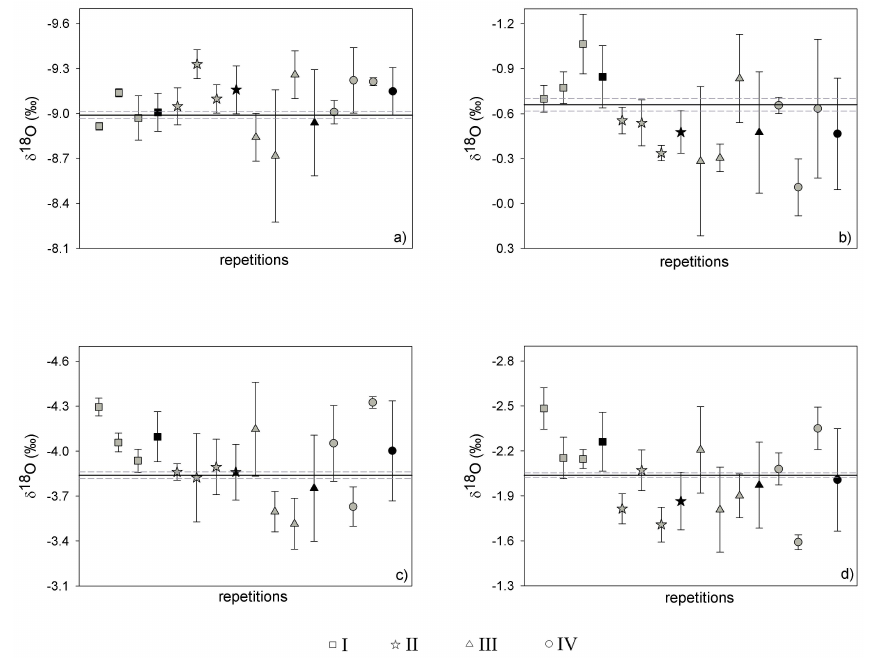
Fig. 8. Repeatability plots of δ 18 O measurements (A1 scheme). The mean value among the three repetitions is represented by the darker symbol. Solid and dashed horizontal lines represent the mass spectrometer δ 18 O measurement and the standard deviation, respectively. Samples: (a) 14; (b) 25; (c) 23; (d) 24.